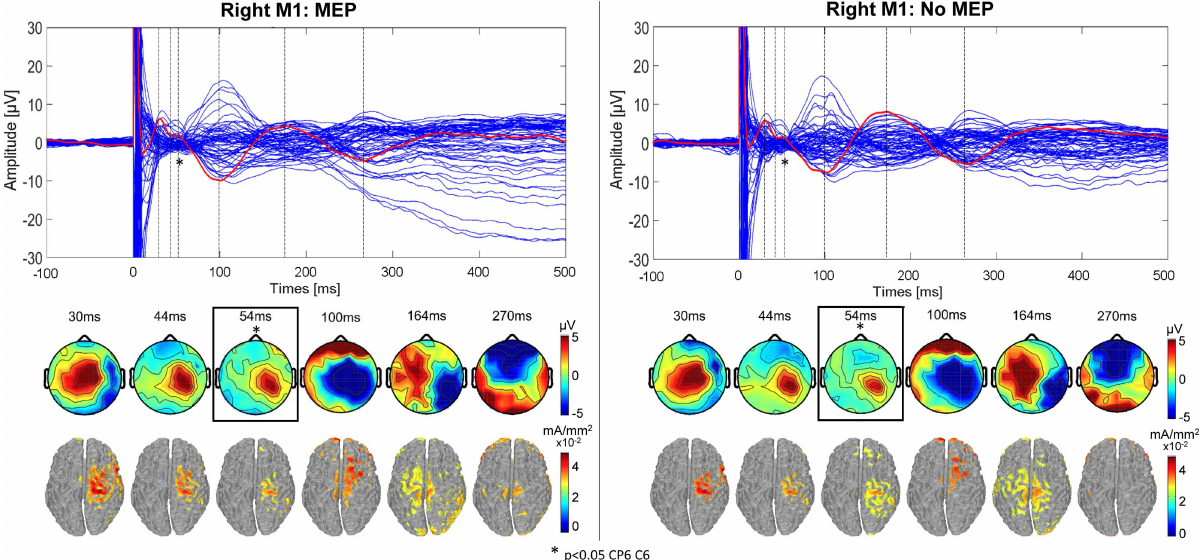
Fig 4. TEPs for right M1 stimulation for MEP and no-MEP trials. (Upper)Butterfly plot of the averageTMS-evoked activity from all electrodes(average of 11 participantswith simultaneous EMG recording)for trials with an MEP (left) and those without (right). Red line indicatesCz electrode. Timing of the peaks is indicatedby vertical dashed lines. (Lower) Voltage distributions and cortical current density estimates of the TMS-evoked activity for each peak in the Cz waveform. The blue boxes and asterisks highlight the 54ms latency, for which the topographysignificantly differed betweenthe MEP and no-MEP conditionsfor electrodesCP6 and C6 ( p < 0 . 05 ).